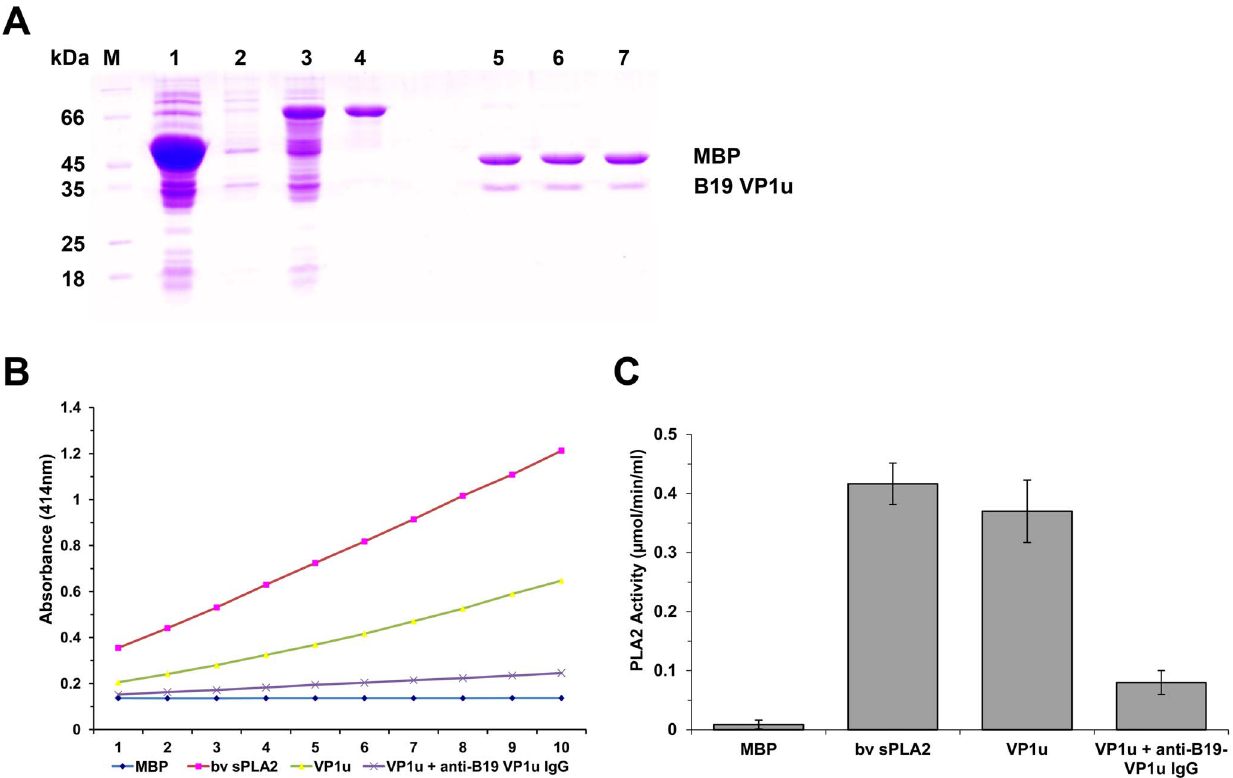
Figure 1. Purified VP1u proteins and PLA2 activity. (A) SDS-PAGE analysis of expressed fusion protein and the purified protein VP1u or mutants cleaved by Factor Xa digestion. M: Protein marker; lane 1: Total protein of E. coli DH5 a transformed with pMAL-c 2 x with IPTG induction; lanes 2 and 3: Total protein of E. coli DH5 a transformed with pMAL-VP1u with or without IPTG induction, respectively; lane 4: Purified fusion protein MBP-VP1u; lanes 5, 6, and 7: Purified VP1u, VP1u-H153A, and VP1u-D195A digested by Factor Xa. (B–C) PLA2 activity on various substrates as indicated at the bottom. The PLA2 activity is shown as a value of the absorbance at 414 nm at various time points. Purified MBP, 5 m g; bee venom, 10 ng; purified VP1u (5 m g); VP1u (5 m g) with anti-B19 VP1u (5 m g). Data are representative of three independent experiments.